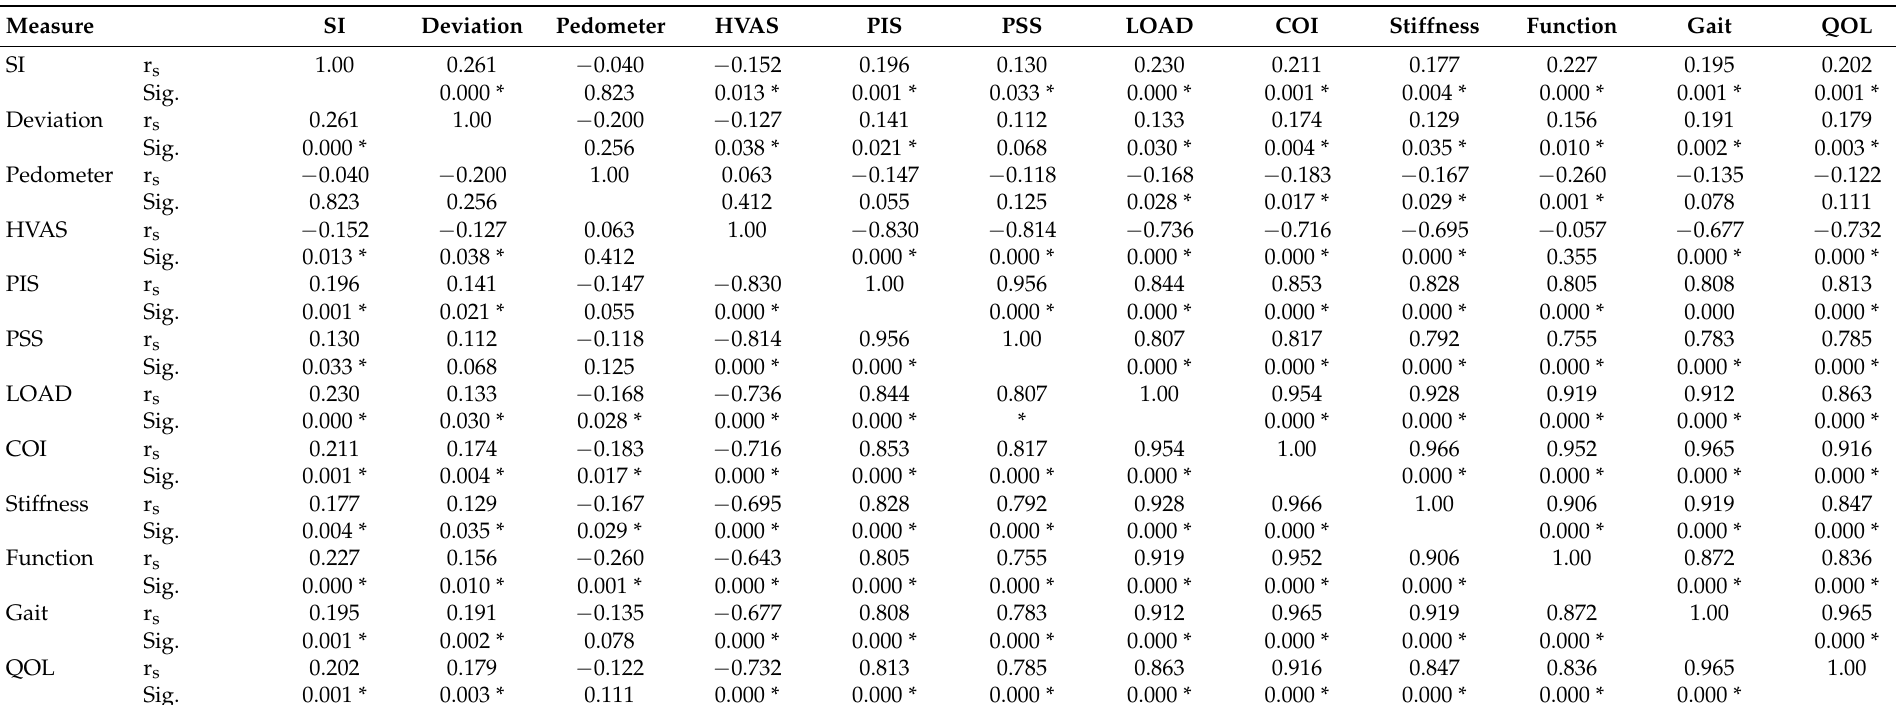
Table 3. Correlations for the longitudinal cohort. COI: Canine Orthopaedic Index; HVAS: Hudson Visual Analogue Scale; LOAD: Liverpool Osteoarthritis in Dogs; PIS: Pain Interference Score; PSS: Pain Severity Score; QOL: quality of life; SI: symmetry index. *: indicates significant